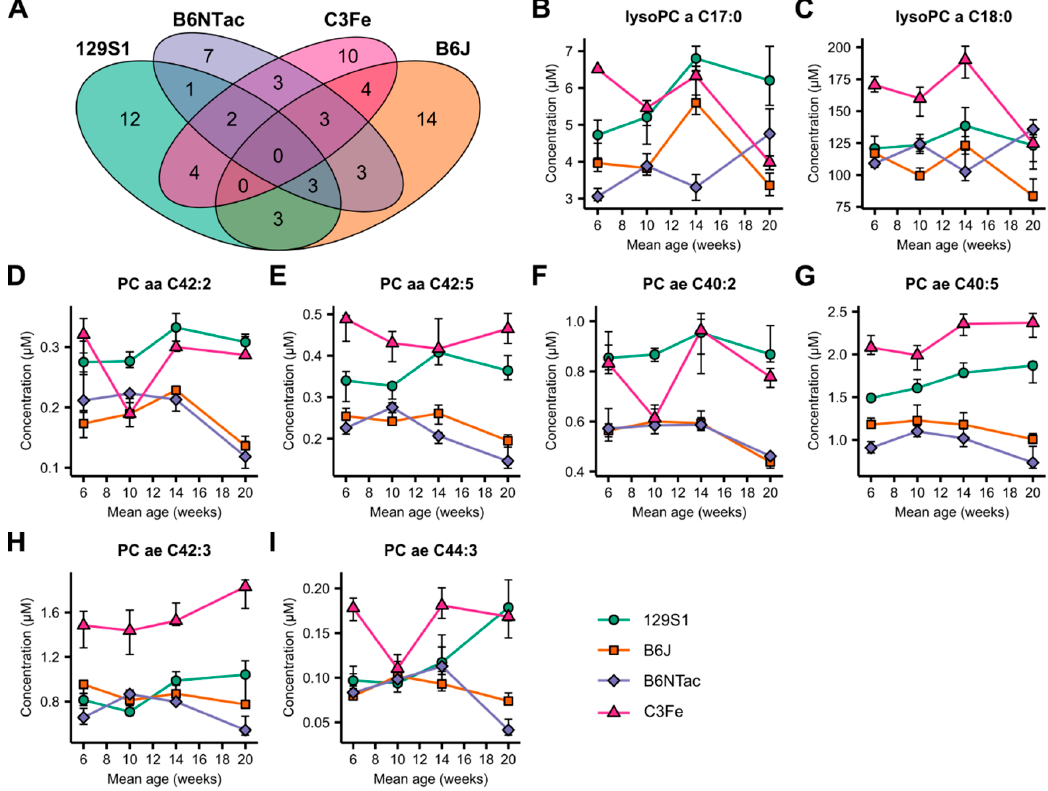
Figure 2. Inter-strain comparison of age-dependent changes in the plasma metabolome of female mice. ( A ) Venn diagram depicting the overlap of strain-specific age-dependent metabolites. ( B – I ) Line-dot plots of metabolites showing age-dependent changes in three out of four mouse strains. Dots and error bars represent median and interquartile range (IQR), respectively. Fold changes and p -values can be found in Supplementary Table S5.